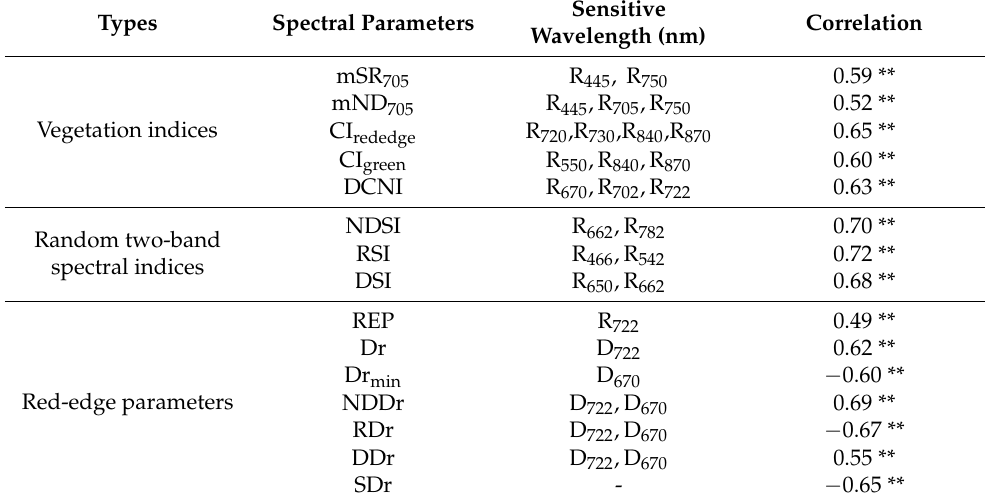
Table 3. Correlation between spectral parameters and